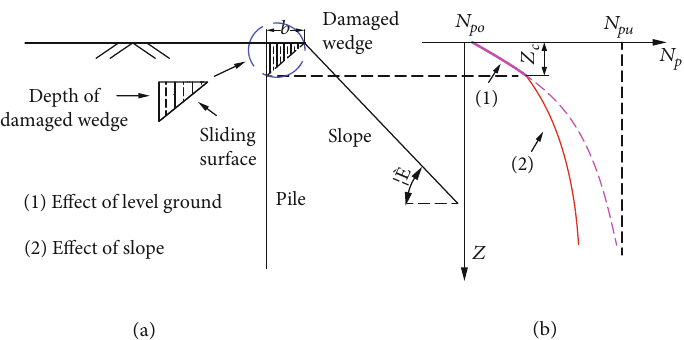
Figure 3: Ultimate soil resistance analytical model with the distance of piles from the crest of the slope. (a) Damaged wedge model of the laterally loaded piles. (b) The N p curve varying with the